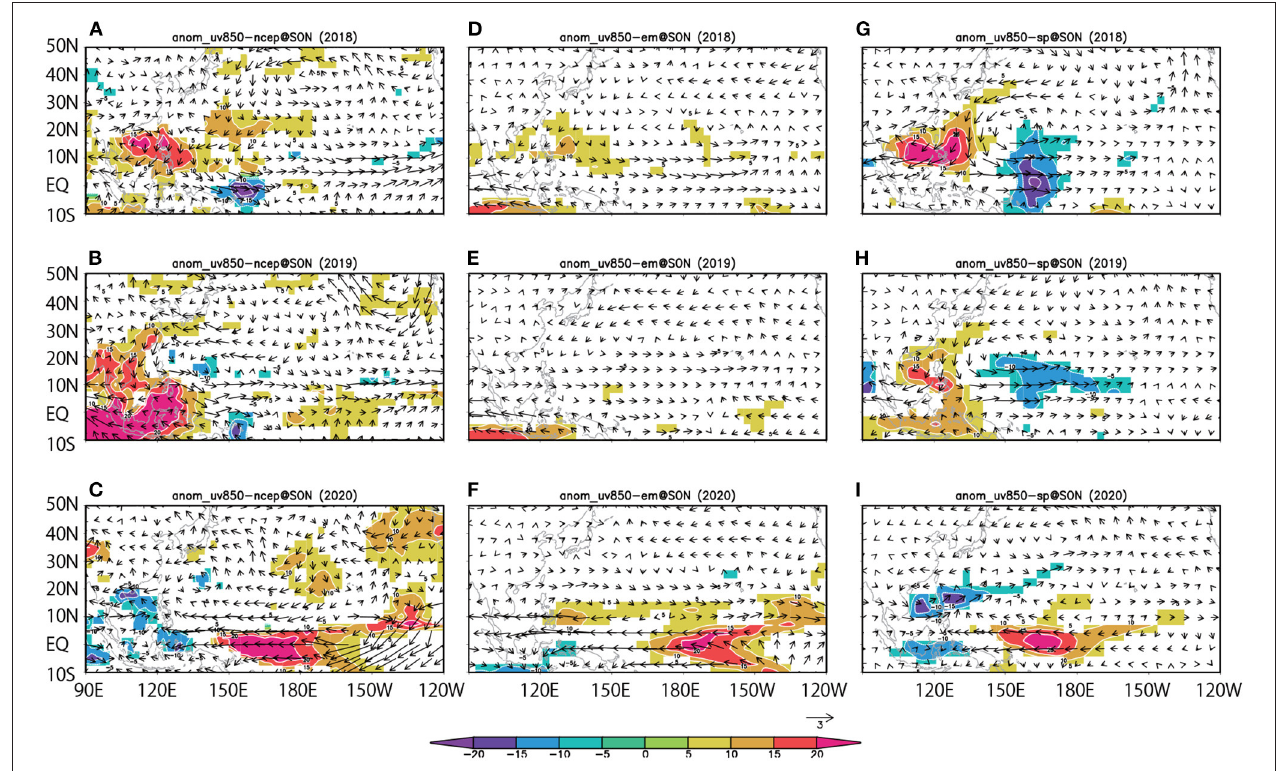
FIGURE 5 | Same as Figure 4 but for SON.